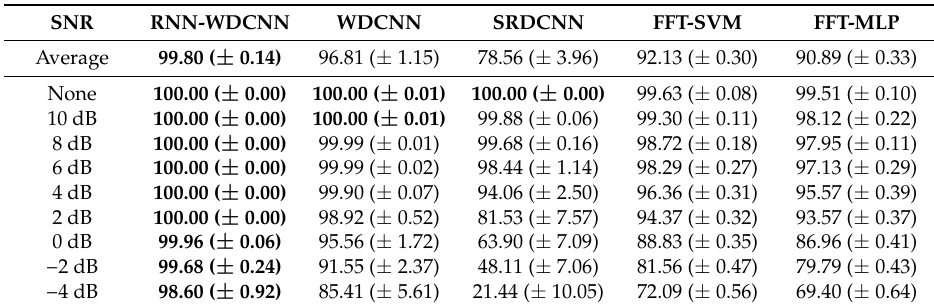
Figure 13. Noise rejection accuracy comparison between RNN-WDCNN and WDCNN, SRDCNN, and FFT based methods (best values are highlighted in bold). Table 13. Precision scores of the models considered in this work (as a percentage) for noise rejection performance (best values are highlighted in